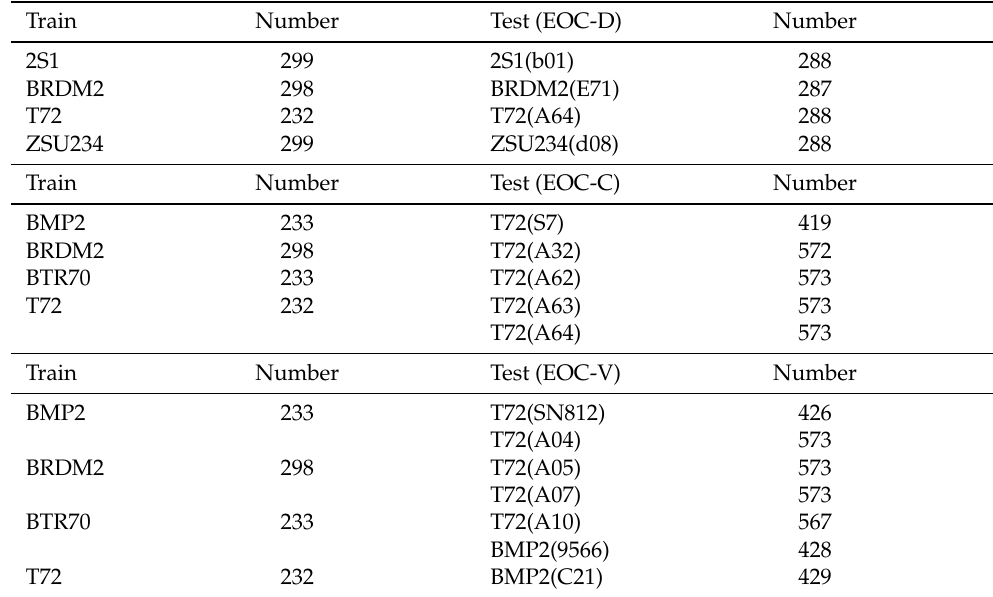
Table 4. Training and testing dataset under EOCs.